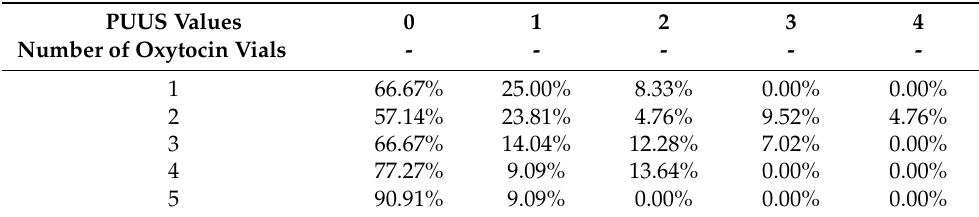
Table 12. The PUUS values of patients regarding the number of oxytocin vials received during the third stage of labor.